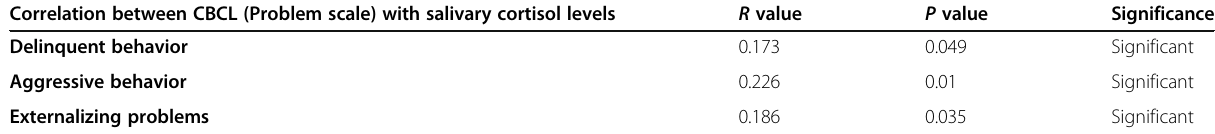
Table 3 Correlation between salivary cortisol level and behavior problems assessed by CBCL in the ADHD group Correlation between CBCL (Problem scale) with salivary cortisol levels R